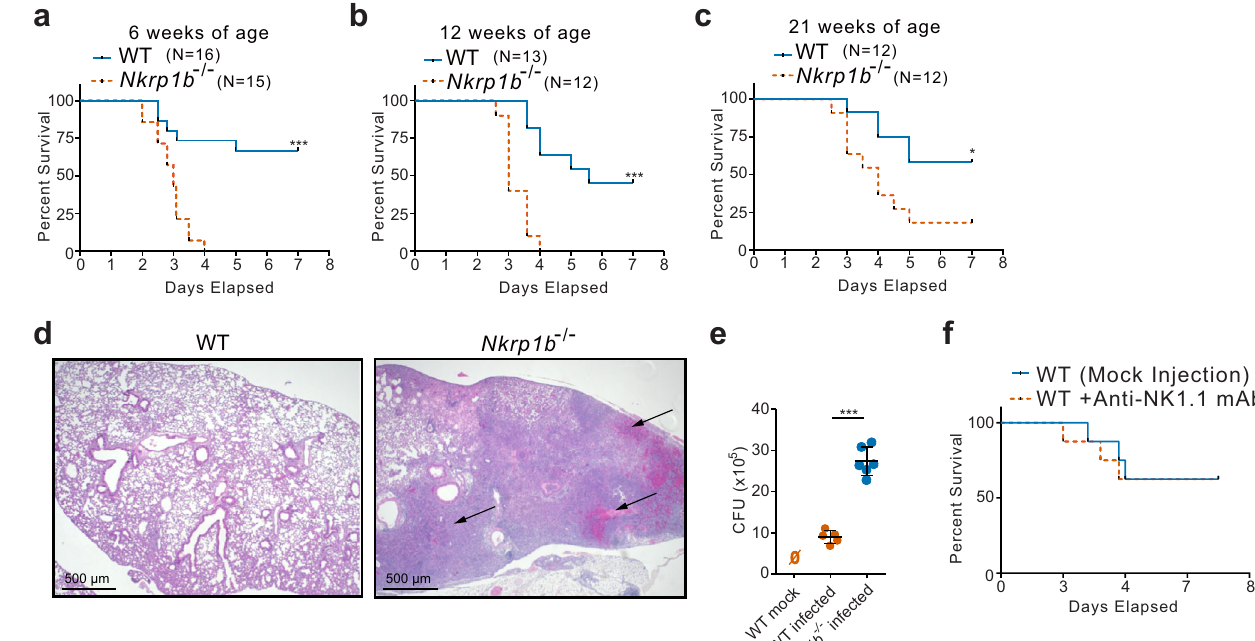
Fig. 1 | NKR-P1B-de fi cient mice exhibit greater morbidity and mortality upon pneumococcal infection. a – c Kaplan – Meyer curves of WT versus Nkrp1b − / − mice susceptibility to S. pneumoniae at 6-, 12-, and 21 weeks of age, respectively. WT ( n =16, 13, and 12, respectively), Nkrp1b − / − ( n =15, 12, and 12, respectively). * p ≤ 0.005, *** p ≤ 0.001. d Images of mouse lungs stained with H/E, 3 days post- S . pneumoniae infection. Images are representative of three separate experiments. Arrows indicate areas of severe alveolar in fl ammation, bronchopneumonia, and obstructivechangescompoundedwiththedestructionoflocalvasculaturecausing